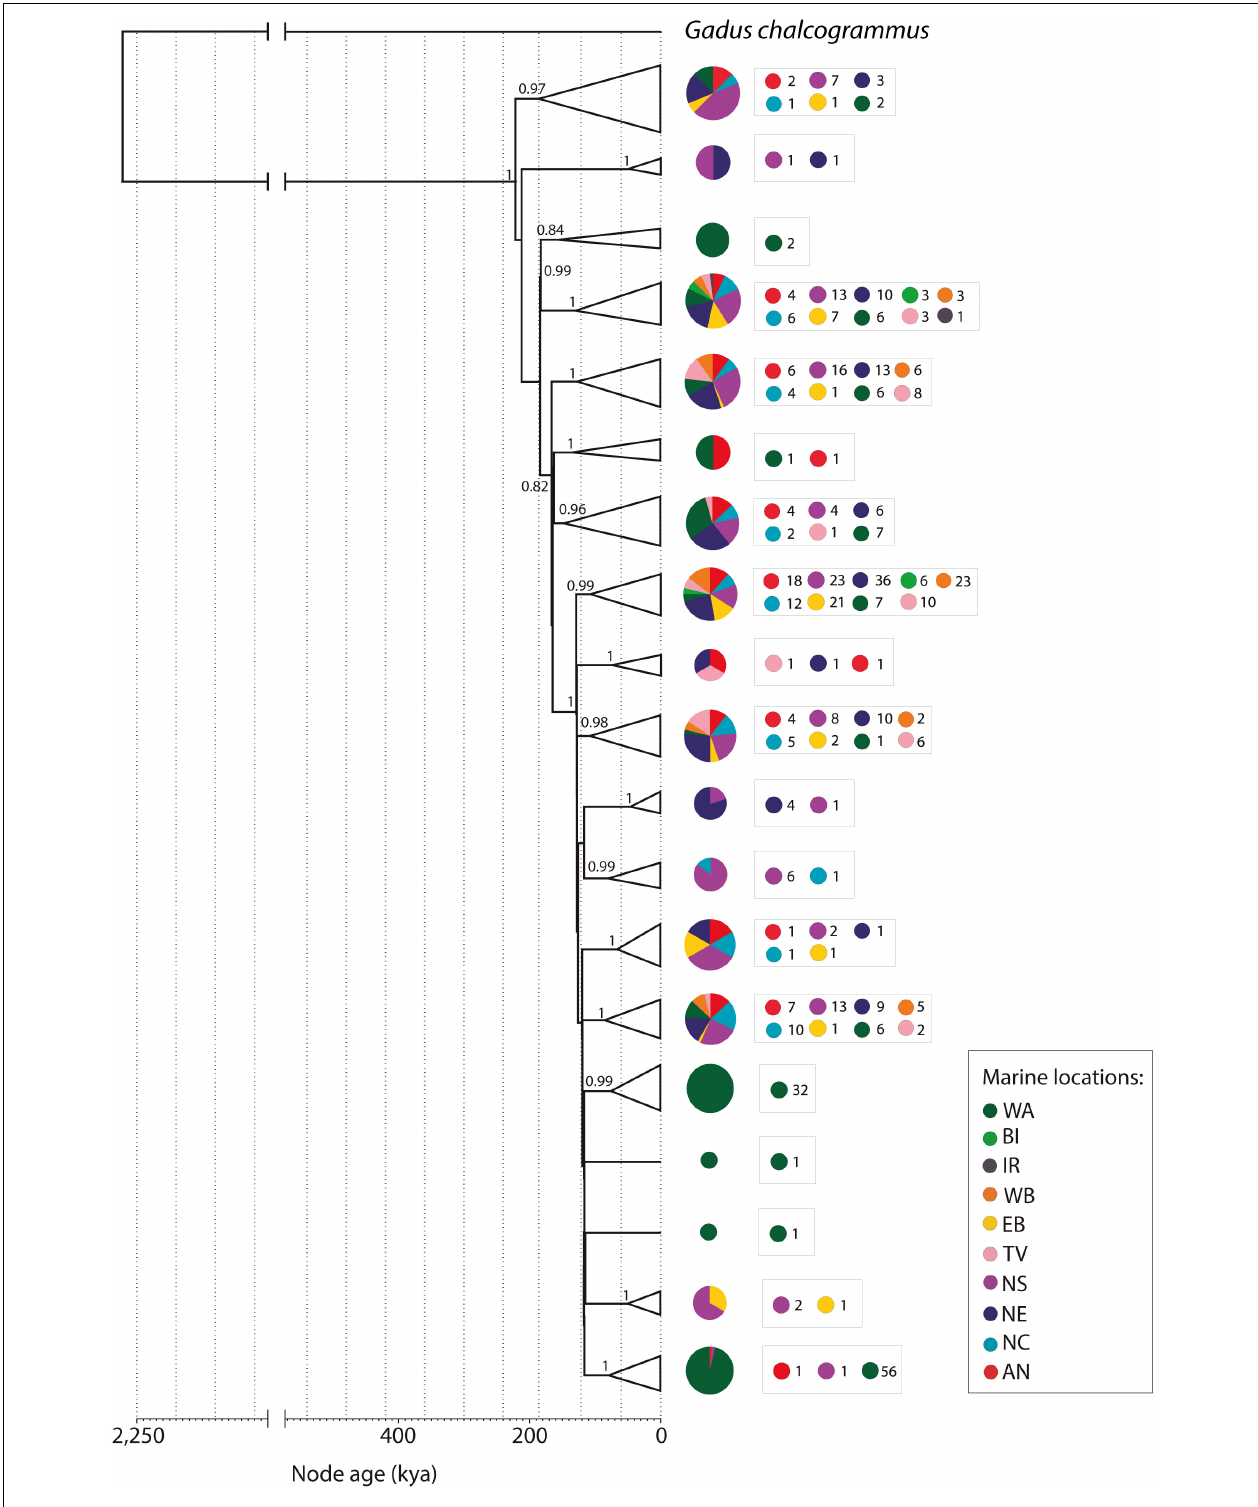
FIGURE 4 | Time calibrated collapsed Bayesian phylogeny of full mitogenomes from 525 Atlantic cod specimens using Alaska pollock ( Gadus chalcogrammus ) as an outgroup. Pie charts represent the marine locations distributed in each clade. Numbers beside pie charts indicate the number of individuals from each marine location distributed in each clade. Only branches with posterior probability > 0.8 are indicated next to the corresponding clade/subclade. For specific distribution of sampling sites of ancient samples see Supplementary Figure 6 .